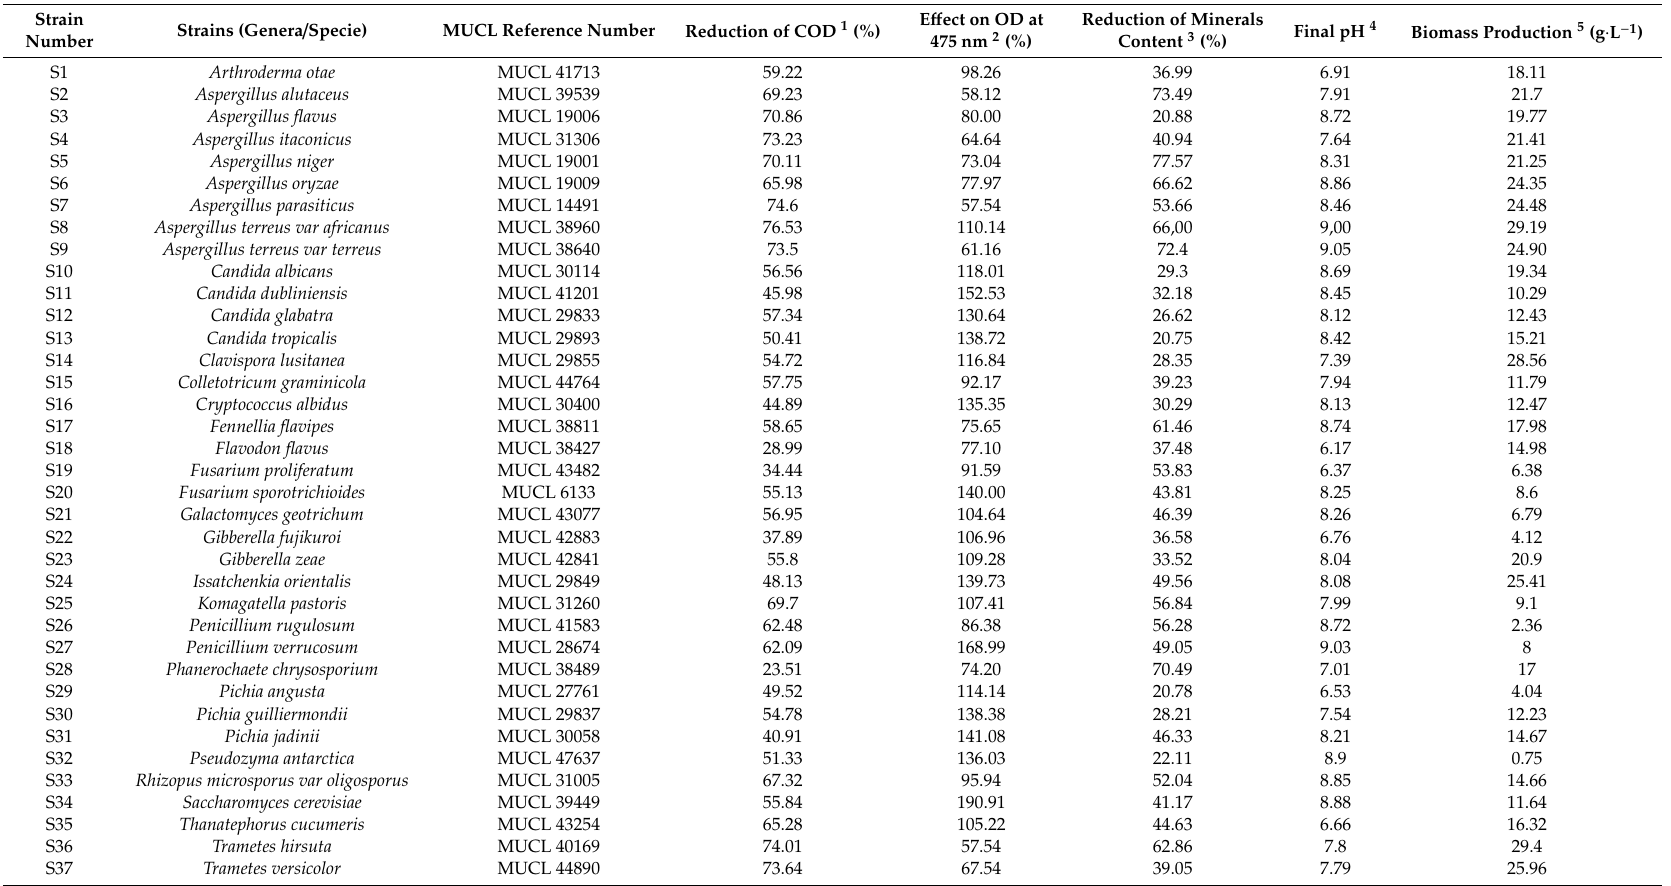
Table 1. Strains used in this study, e ff ects of aerobic treatment of DSW on physicochemical parameters and biomass production. Strain